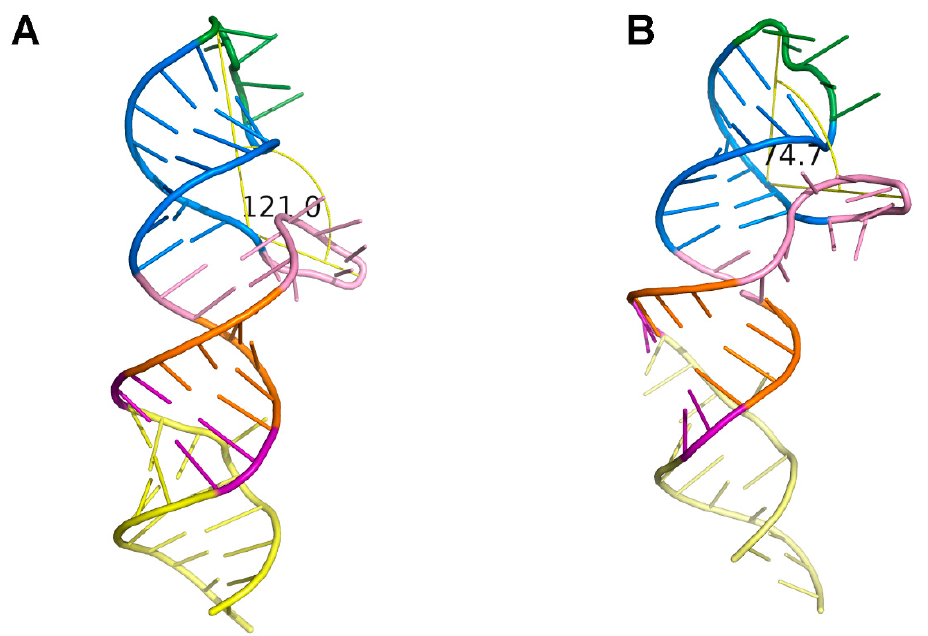
Figure 5. Local rearrangements diagram of ligand binding. ( A ) Angle measurement in the 3D predicted structure in the ligand-free state. ( B ) Angle measurement in the 3D predicted reconstituted structure in the ligand-bound state. The models were predicted with the RNAComposer automated RNA structure 3D modeling server and SHAPE data.